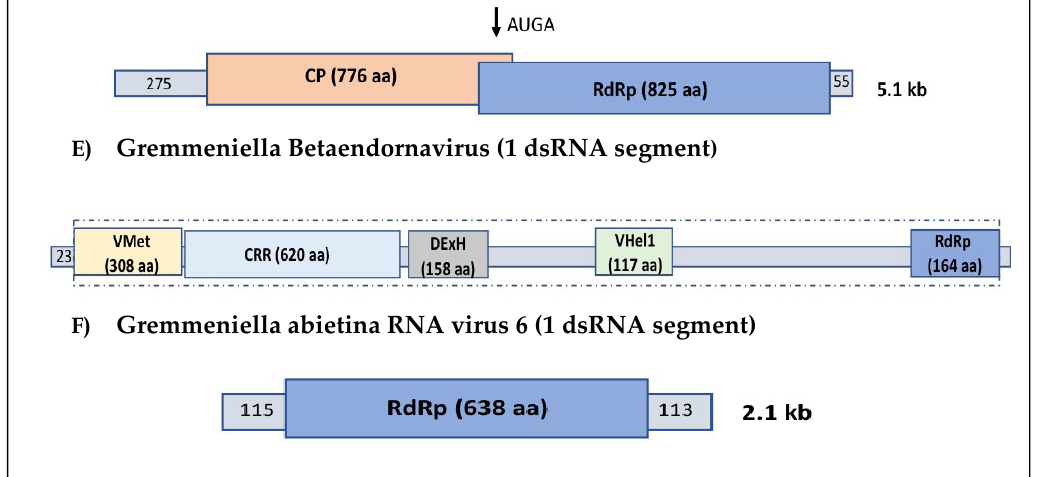
Figure 1. Schematic illustration of the genomic organisation of all fully sequenced G. abietina mycoviruses. ORFs and conserved domains are represented by rectangular coloured boxes indicating the coded proteins and the size of their amino acid sequences. They are flanked by 5′- and 3′-UTRs, numbers represent base pairs (bp). The full-length dsRNA segment size is indicated on the right. ( A ) Gremmeniella abietina RNA virus-MS1; ( B ) Gremmeniella mitovirus 1 (previously named Gremmeniella abietina RNA virus-S1); ( C ) Gremmeniella mitovirus 2; ( D ) Gremmeniella abietina RNA virus-L; ( E ) Gremmeniella betaendornavirus 1 (previously Gremmeniella abietina RNA virus-XL) consists of a polyprotein of 3249 and five conserved regions: viral methyltransferase (VMet), cysteine-rich region (CRR), DExH box helicase (DExH), viral RNA helicase 1 (VHel1), and RNA_dep_RNApol2 (RdRp); ( F ) Gremmeniella abietina RNA virus 6.